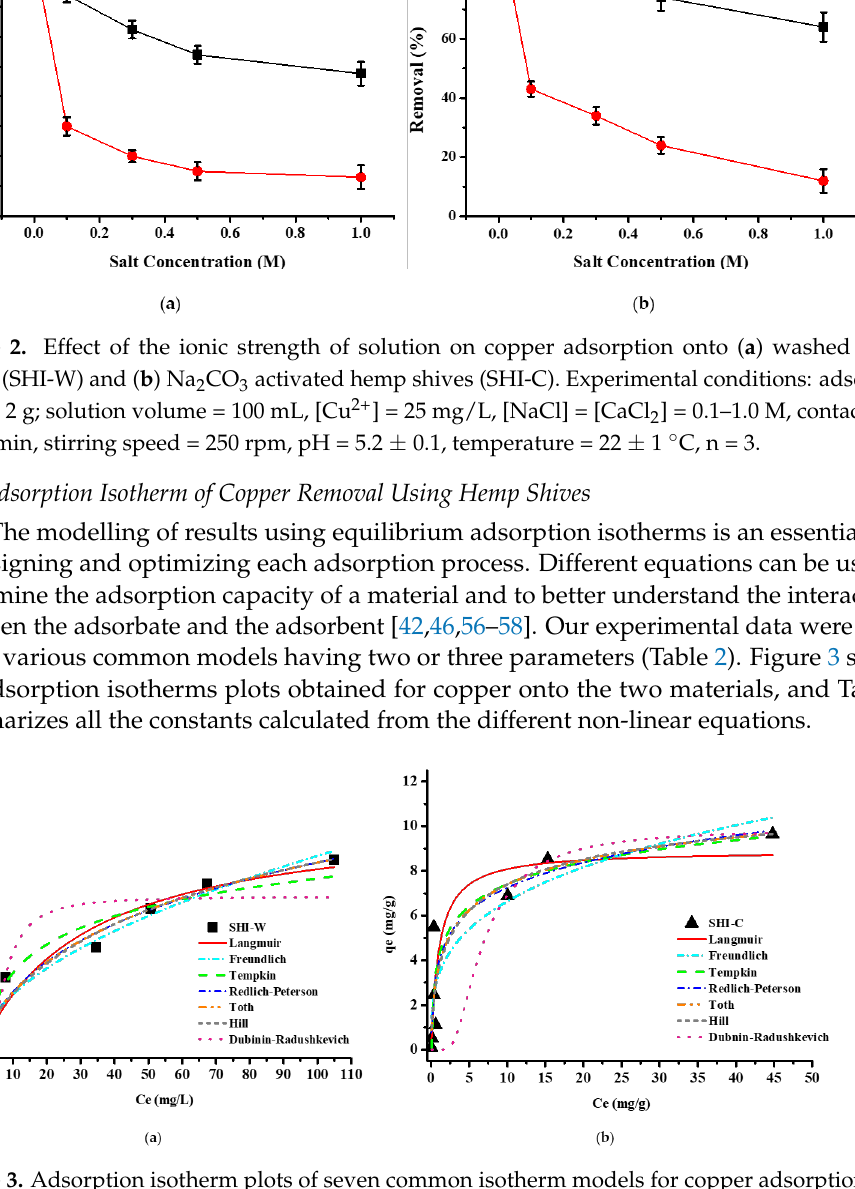
Figure 3. Adsorption isotherm plots of seven common isotherm models for copper adsorption onto ( a ) washed hemp shives (SHI-W) and ( b ) Na 2 CO 3 activated hemp shives (SHI-C). Table 3. Isotherm parameter constants for copper adsorption onto washed (SHI-W) and Na 2 CO 3 activated (SHI-C) hemp shives obtained using seven common isotherm models. Model